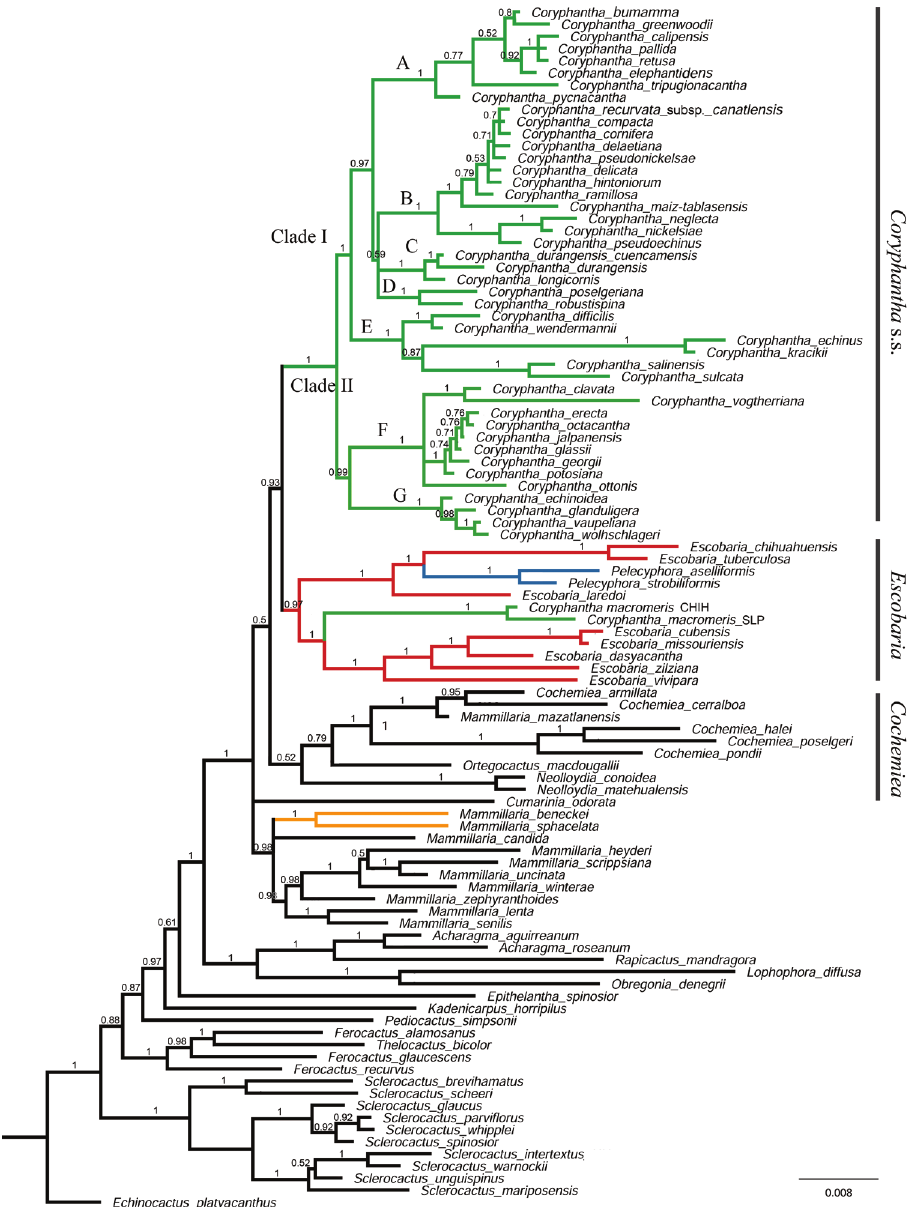
Figure 2. Phylogenetic relationships of Coryphantha and close related genera. Majority rule phylogram, from the BI analysis using cpDNA sequences, indels, and morphological partitions (combined analysis). Numbers in nodes indicate posterior probabilities. Labels indicate the main recovered clades and